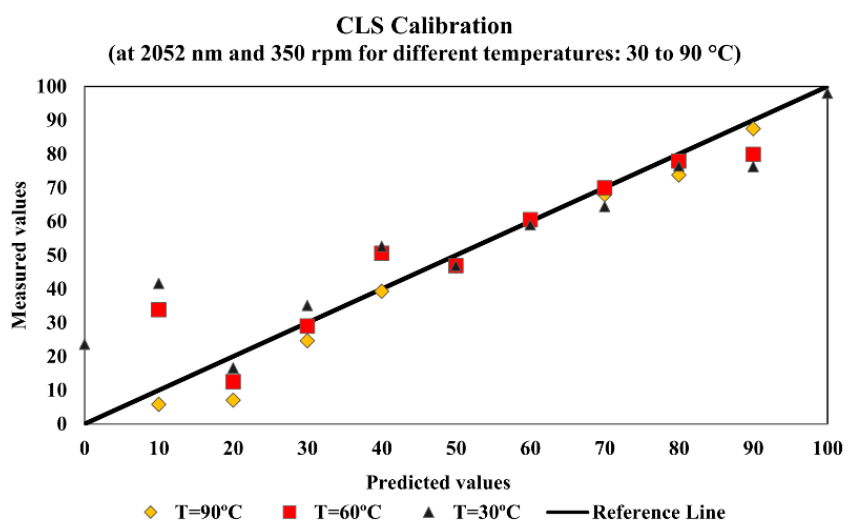
Figure 2. Simple linear calibration model performance at 2052 nm for stirring speed of 350 rpm.